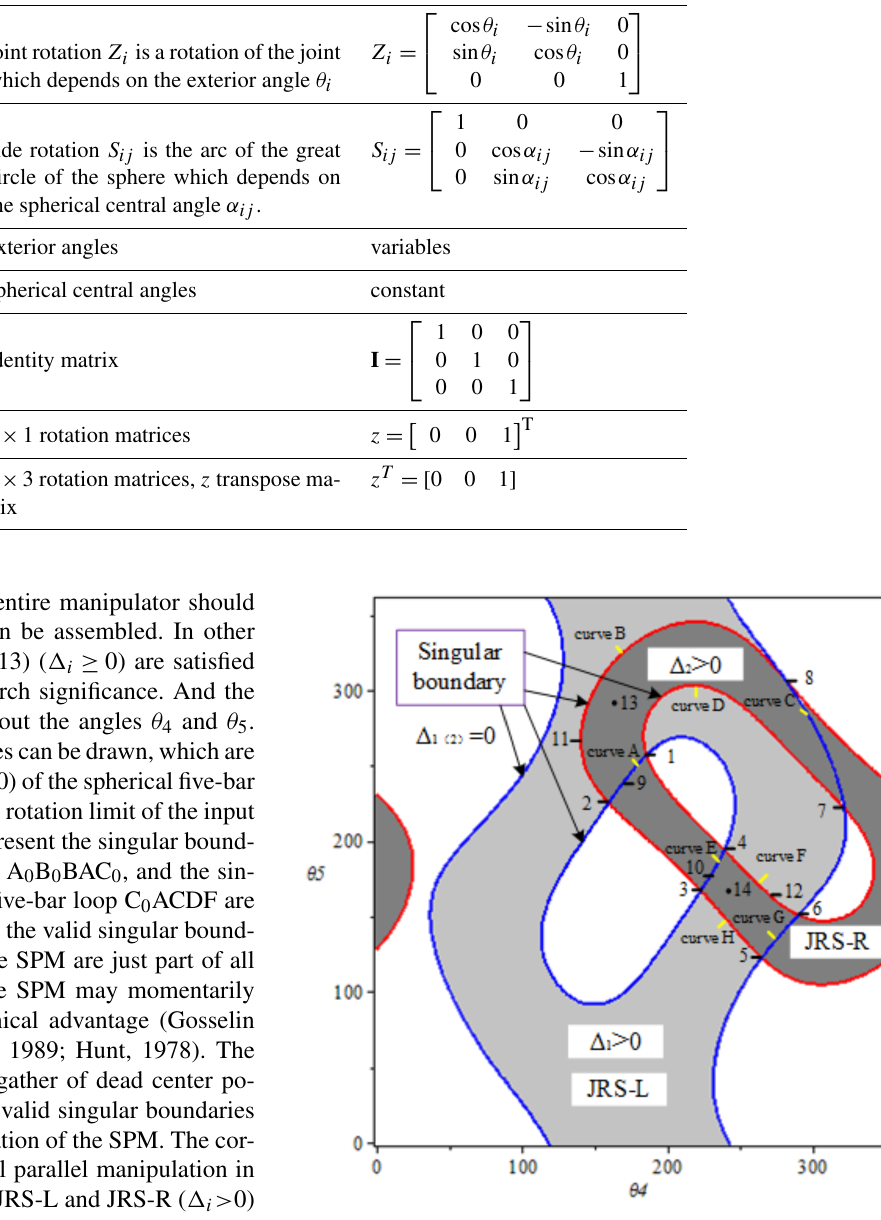
Figure 4. Singular boundaries of two spherical five-bar